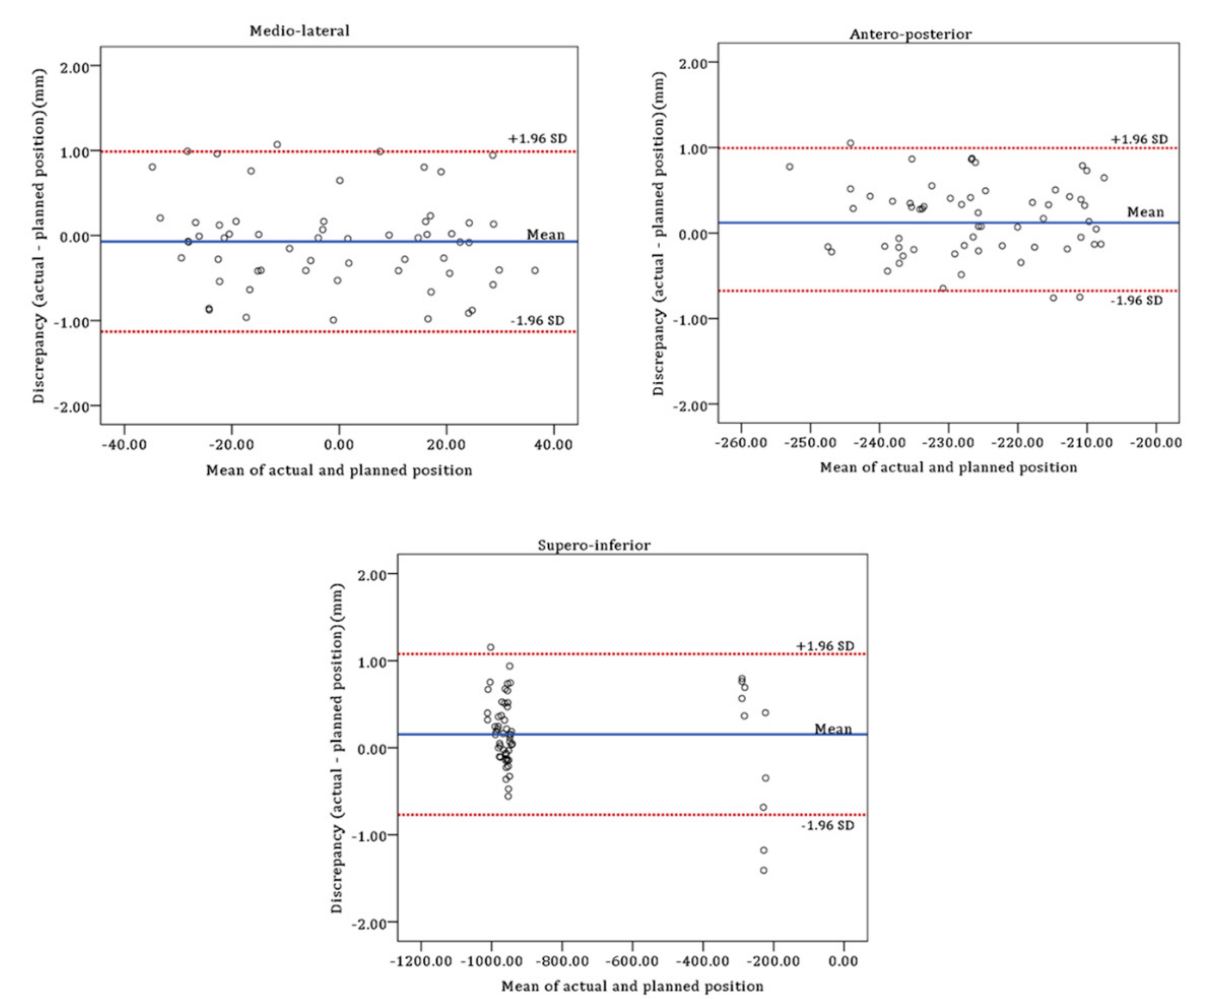
Figure 8. Bland-Altman plot of the differences in the medio-lateral, antero-posterior, and supero-inferior directions between the planned and actual postoperative maxillary positions.